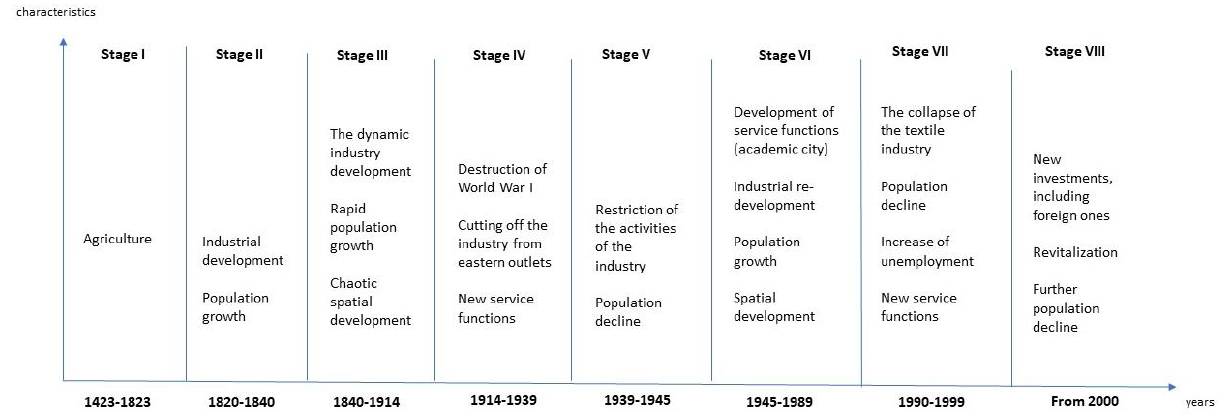
Fig. 2. The development of Łódź over the years (Source: own elaboration based on Jakóbczyk-Gryszkiewicz, 2011)